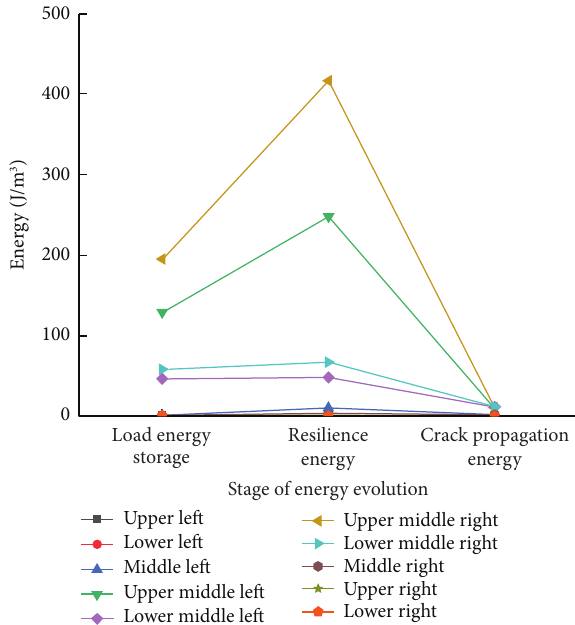
Figure 10: Energy characteristics of local feature points.